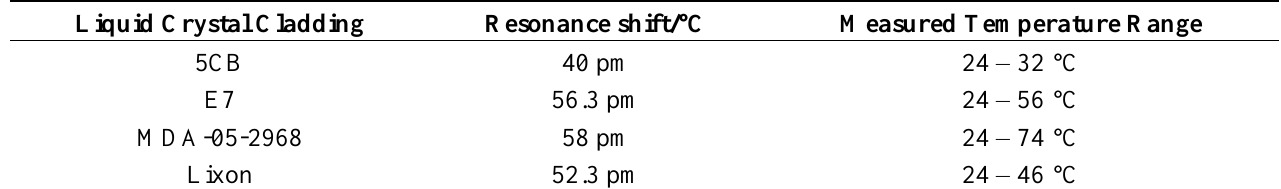
Table 2. Summary of results appearing in Figure 2.